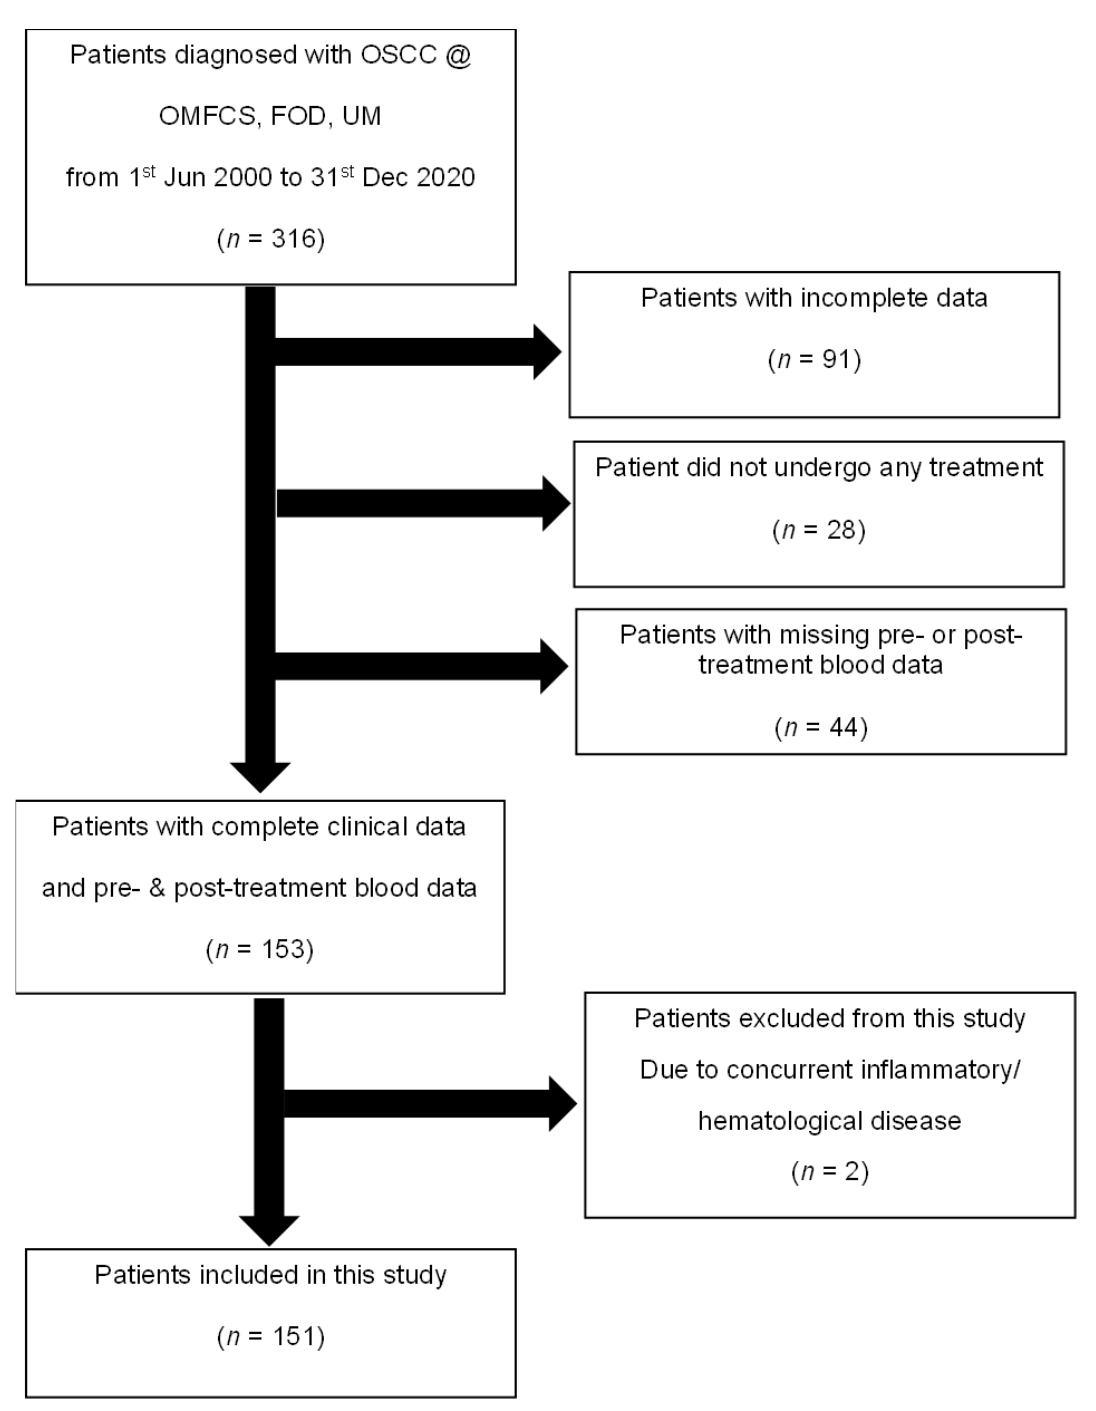
Figure 1. Flowchart explaining the patient selection process for this